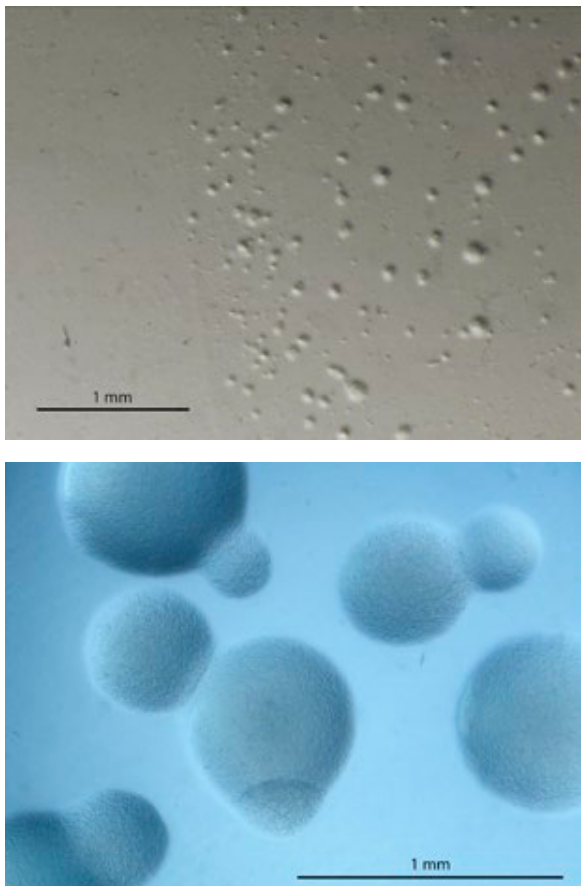
Figure 3. Colonies growing on agar. photographed at be- tween ×12 and ×50 magnification. A), Mycoplasma bovis colonies incubated for 2 d on P iv S medium in an atmos- phere of 95% N 2 /5% CO 2 at 36 + 1°C. B), phytoplasma colonies from a plating of the acidified culture in Figure 2 photographed after 2 d days incubation. (C), subculture growth of phytoplasma colonies of an isolate from a STOL infected shoot after 5 d incubation. D), subculture growth of phytoplasma colonies of an isolate from a PD infected shoot after 5 d incubation. (E), single colony from a culture derived from a shoot infected with strain CY-TO after 10 d incubation. Uninoculated area to the left of the